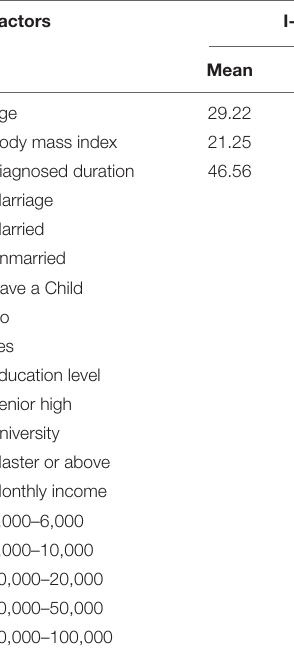
TABLE 2 | Socioeconomic characteristics.